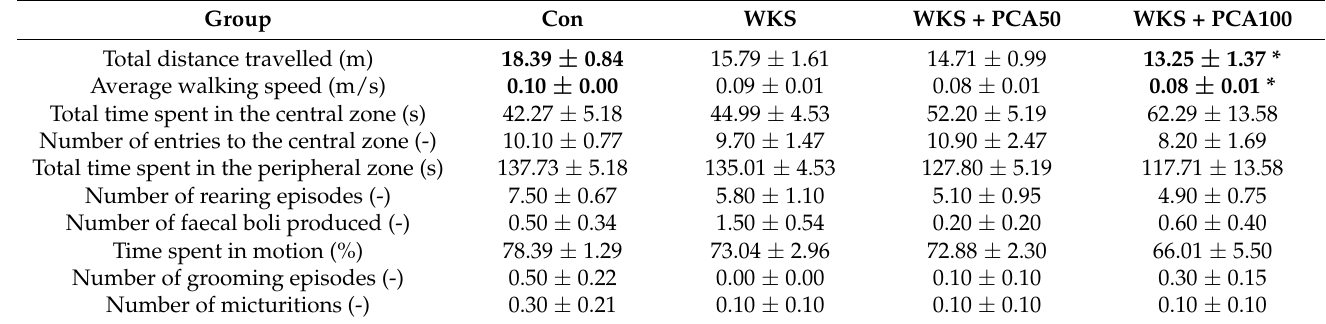
Table 1. Effect of long-term oral administration of PCA at doses of 50 mg/kg or 100 mg/kg on the behaviour of rats in the Open Field test in PTD model of